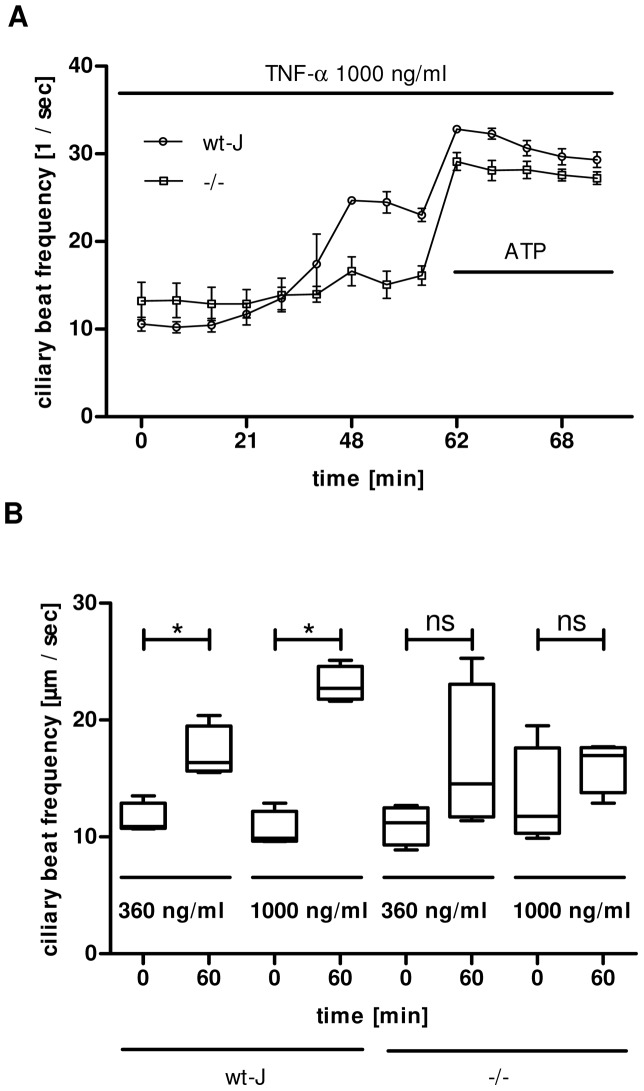
TNF-α effects are reduced in TNF-R1−/− mice.
A: The recording shows the highest concentration of TNF-α (1000 ng/ml) applied. In wt-J mice it resulted in an increase of the CBF becoming significant between minute 48 and minute 60 compared to TNF-R1−/− mice using Mann Whitney U-test (p<0.05, Mean ± S.E.M.). B: The dose dependency of TNF-α induced increase in CBF in wt-J mice became significant between minute 60 and minute 120 (p<0.05). This significant difference can not be provoked, when TNF-α is applied at TNF-R1−/− tracheae (p>0.05, Mann Whitney U-test. Mean ± S.E.M., n = 40 cells from 4 tracheae out of 4 animals).